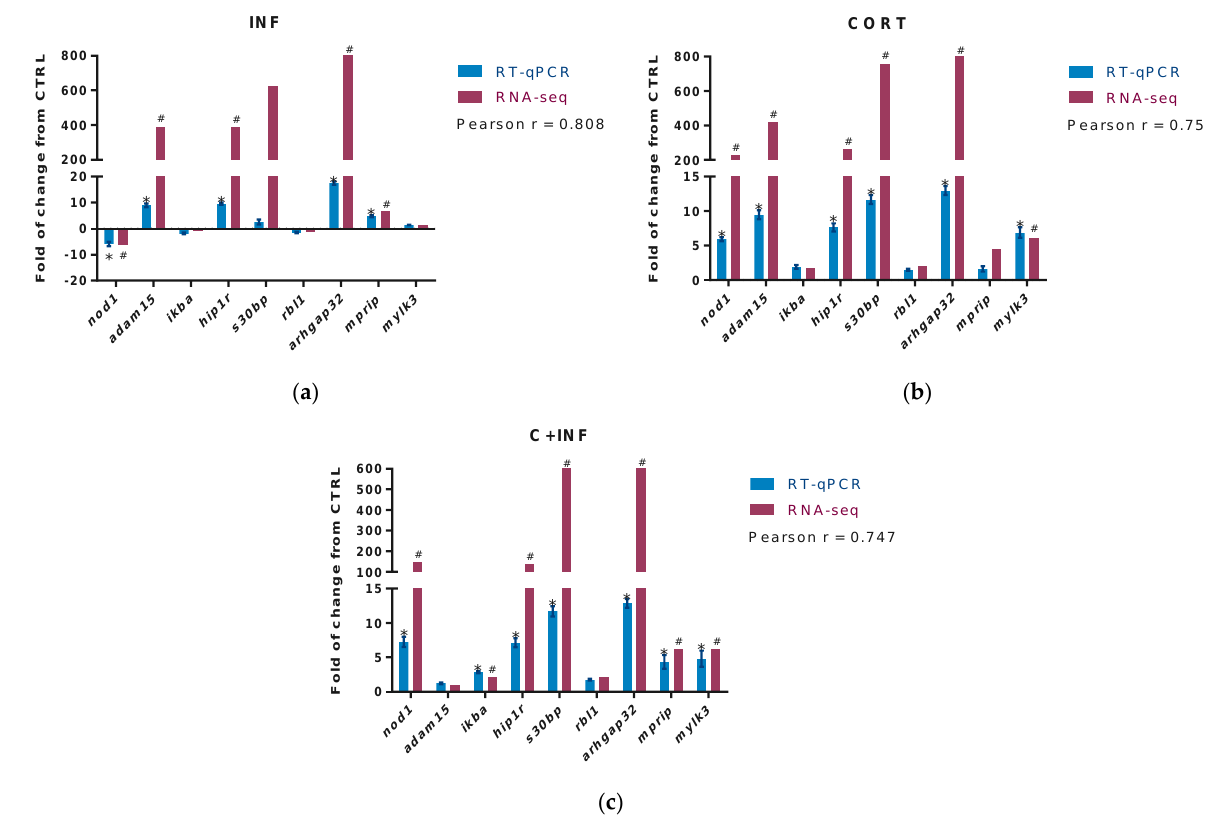
Figure 3. RT-qPCR validation of differentially expressed transcripts. The potential target genes selected for RT-qPCR val- idation of RNA-seq were nod1, adam15, ikba, hip1r, s30bl, rbl1, arhgap32, mprip , and mylk3 . For RNA-seq, “#” indicates fold- change (absolute values > 2.0) and FDR corrected p -value ( p < 0.05). ( a ) Validation between CTRL vs. INF. ( b ) Validation between CTRL vs. CORT. ( c ) Validation between CTRL vs. C+INF. For RT-qPCR, relative expression was normalized against fau and actb , and “*” indicates significant differences from the control (mean ± SEM, n = 3, p < 0.05). Pearson corre- lation (r) between RNA-seq and qPCR are also indicated ( p < 0.05). Abbreviations: CTRL, control; CORT, cortisol; INF, infection; C+INF, cortisol+infection; nod1 , Nucleotide-binding oligomerization domain-containing protein 1; adam15 , Dis- integrin and metalloproteinase domain-containing protein 15; ikba , NF-kappa B inhibitor alpha; hip1r , Huntingtin-inter- acting protein 1-related protein; s30bp , SAP30-binding protein; rbl1 , Retinoblastoma-like protein 1; arhgap32 , Rho GTPase activating protein 32; mprip , myosin phosphatase Rho interacting protein; mylk3 , myosin light chain kinase 3; fau , 40S ribosomal protein S30; actb , β-actin. Our results present high correlations in the group infected with P. salmonis (r = 0.808), in the group treated with cortisol (r = 0.756), and in the group pretreated with cortisol and infected with P. salmonis (r = 0.747), between the expression values of those candidate genes used in the RNA-seq and RT-qPCR. In the mRNA levels of P.salmonis genes, no expression was detected in the CTRL and CORT groups. The results indicate the significant upregulation of the ahpC and 23s genes